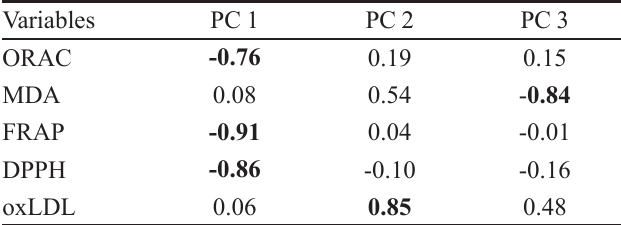
TABLE II - Factor coordinates of variables, based on correlations